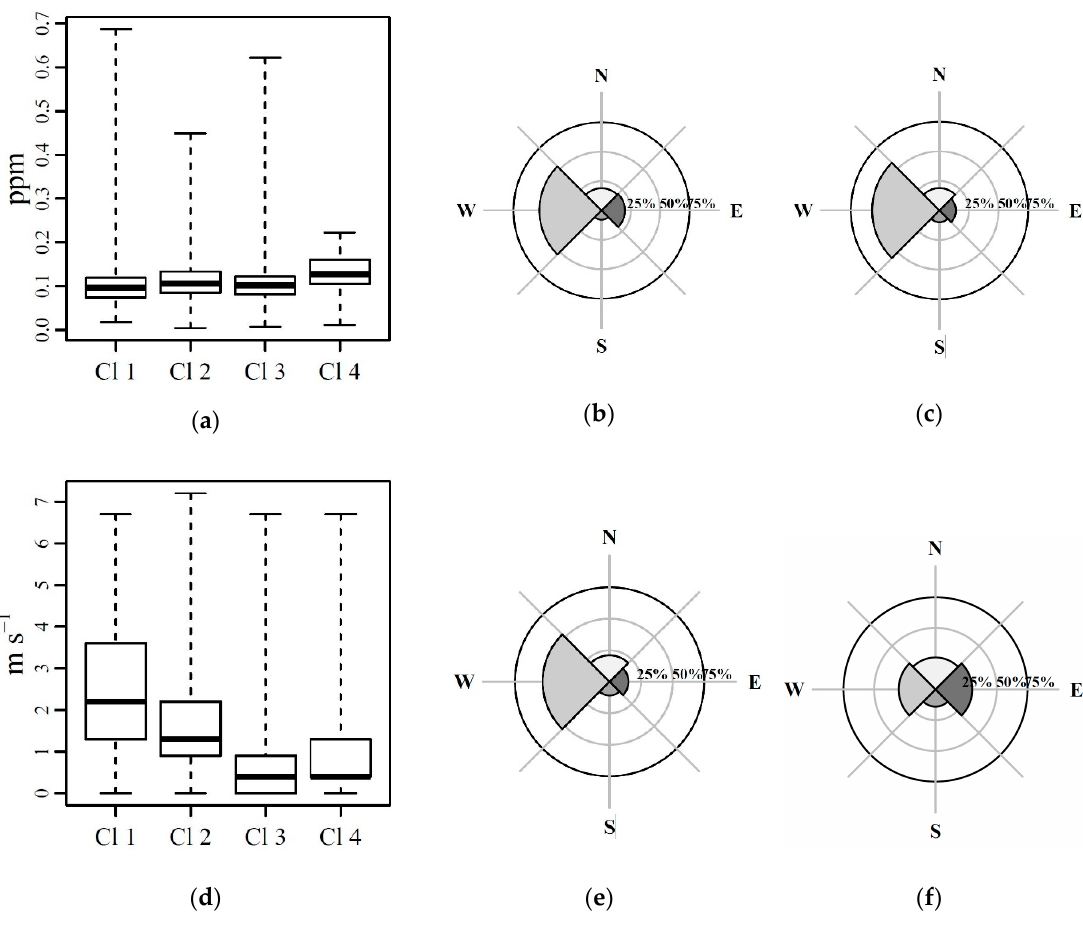
Figure 8. ( a ) Photoionization detector (PID) data distribution according to clusters represented by boxplots; ( b ) wind sector direction percentage for cluster 1; ( c ) wind sector direction percentage for cluster 2; ( d ) wind speed distribution according to clusters represented by boxplots; ( e ) wind sector direction percentage for cluster 3; and ( f ) wind sector direction percentage for cluster 4.